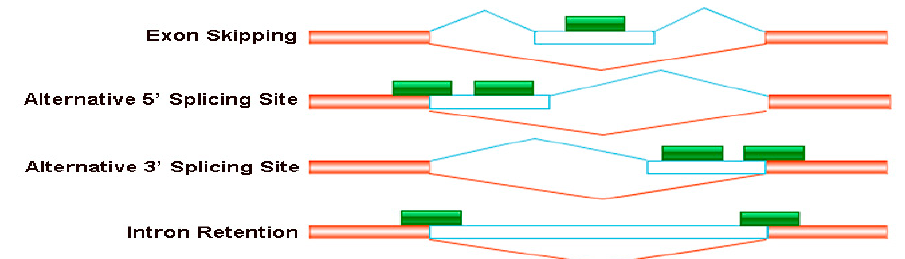
Figure 3. Four major types of the alternative splicing events occurred in B. napus cultivars Qingyou10 and Westar10. Exon skipping (ES), alternative 5 ′ splice site (A5SS), alternative 3 ′ splice site (A3SS), and intron retention (RI) are shown schematically. The orange/transparent boxes represent exons, green boxes represent sequencing reads and lines represent introns.